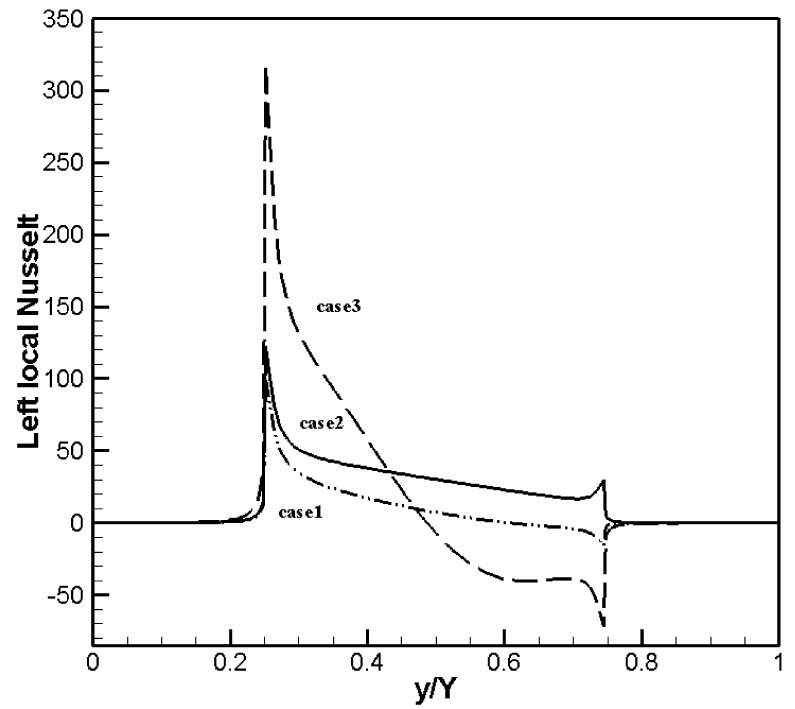
Figure 18. Variation of local Nusselt number along the central partially heated left boundary (Cu- water nanofluid) for different left wall Bcs (boundary conditions) (case 1: Dirichlet constant boundary condition, case 2: linear boundary condition, case 3: Sinusoidal boundary condition) at Ra = 10 5 and volume fraction φ =